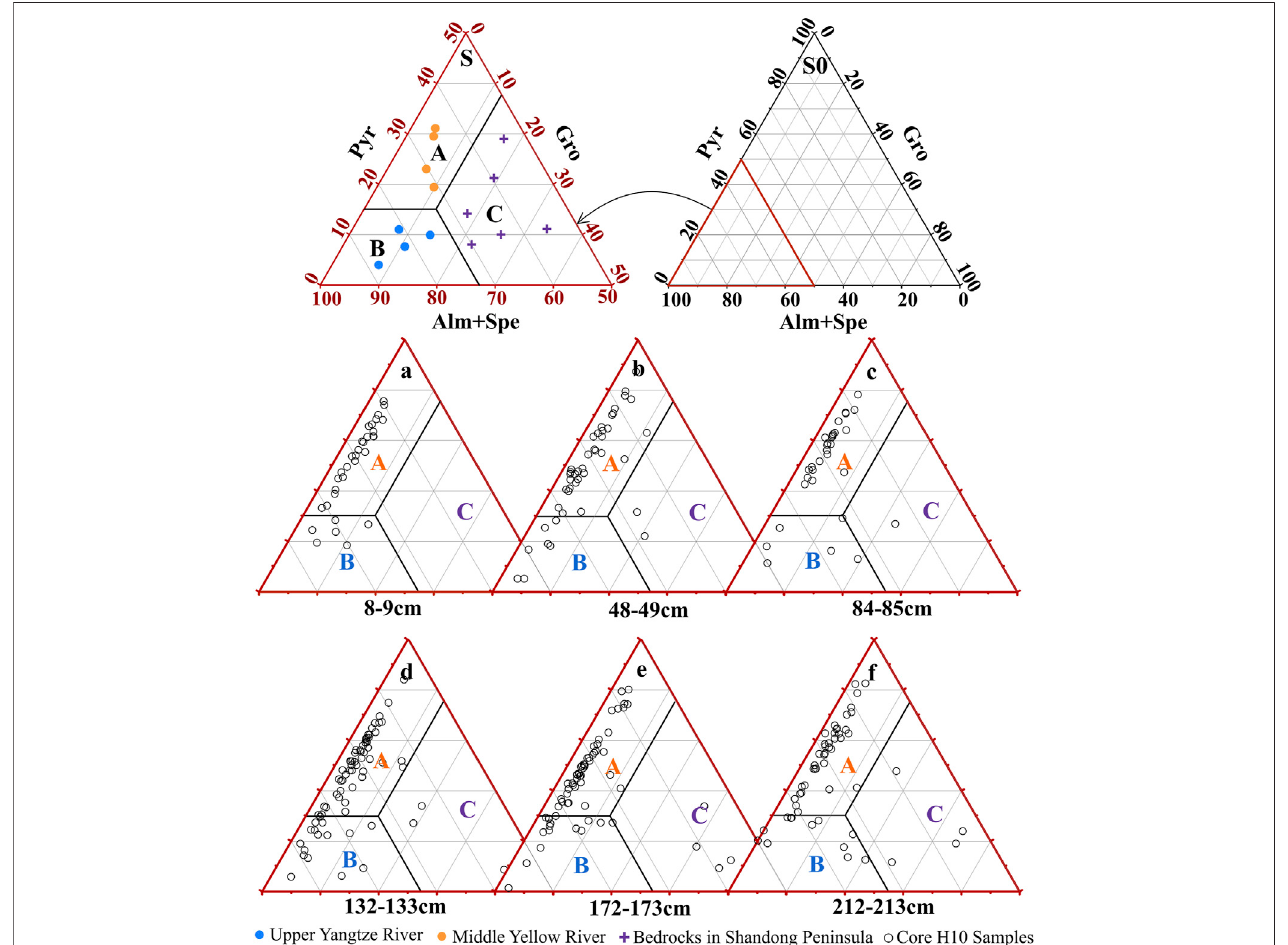
FIGURE 7 | Garnet G – P – AS ternary diagram (s0) for the upper Yangtze River, middle Yellow River (Wang, 2014), bedrock in the Shandong Peninsula (s, Liu et al., 2010b),andcoreH10 (A – F) .A,B,andCrepresenttheprovenanceareasoftheYellowRiver,YangtzeRiver,andShandongpeninsula,respectively.G,grossular(Gro);P, pyrope (Pyr); A, almandine (Alm); and S, spessartine